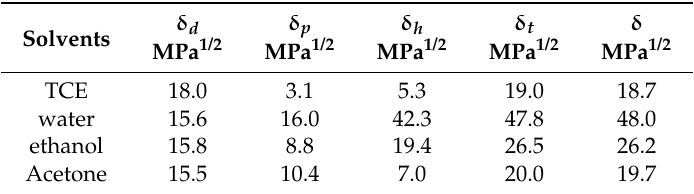
Table 4. Hildebrandt and Hansen solubility parameters of the aqueous phase (water), the oil phase (TCE), and two compatabilizers: ethanol and acetone